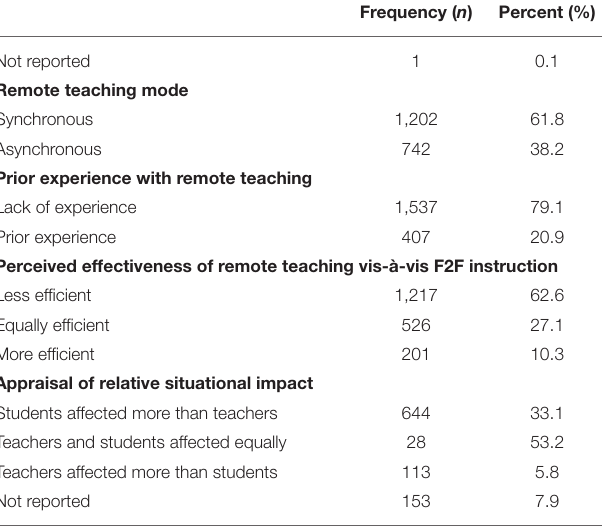
TABLE 1 | Sociodemographic characteristics of the participants ( N =